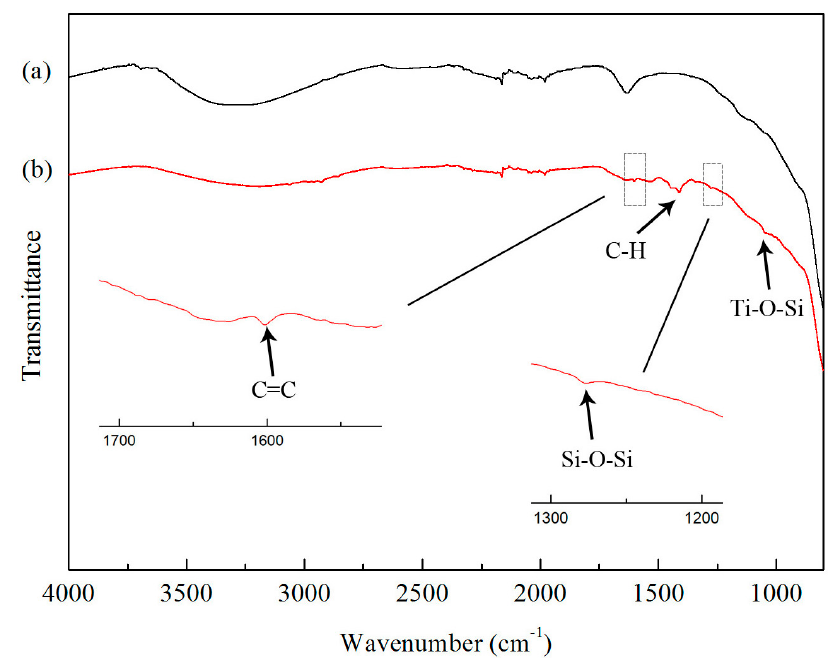
Figure 4. FTIR spectra of ( a ) untreated TiO 2 and ( b ) A171-grafted TiO 2 nanoparticles.